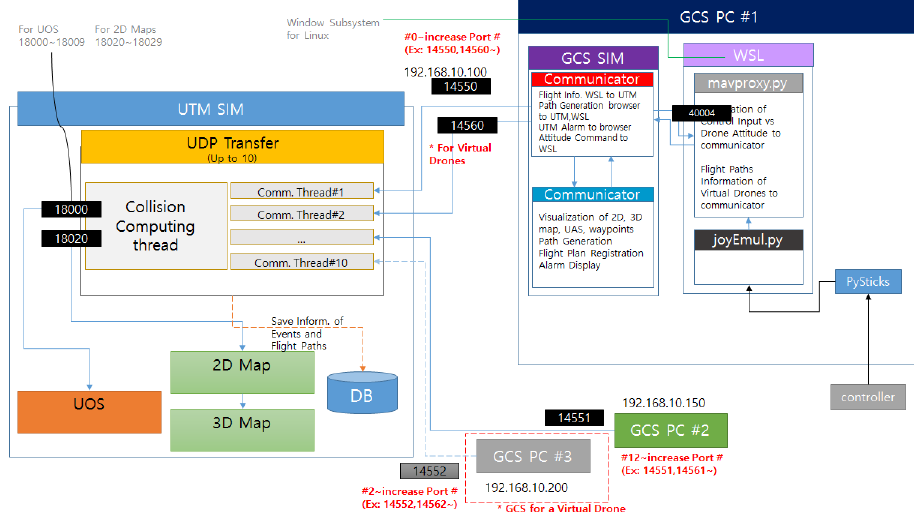
Figure 8. Overall system configuration of eUTM.